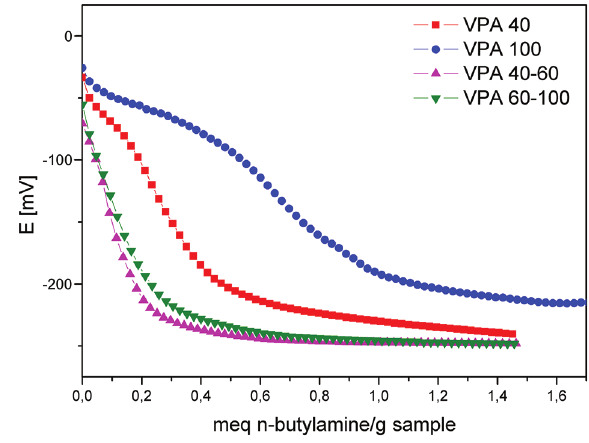
Figure 5: Potentiometric titration of PVA.